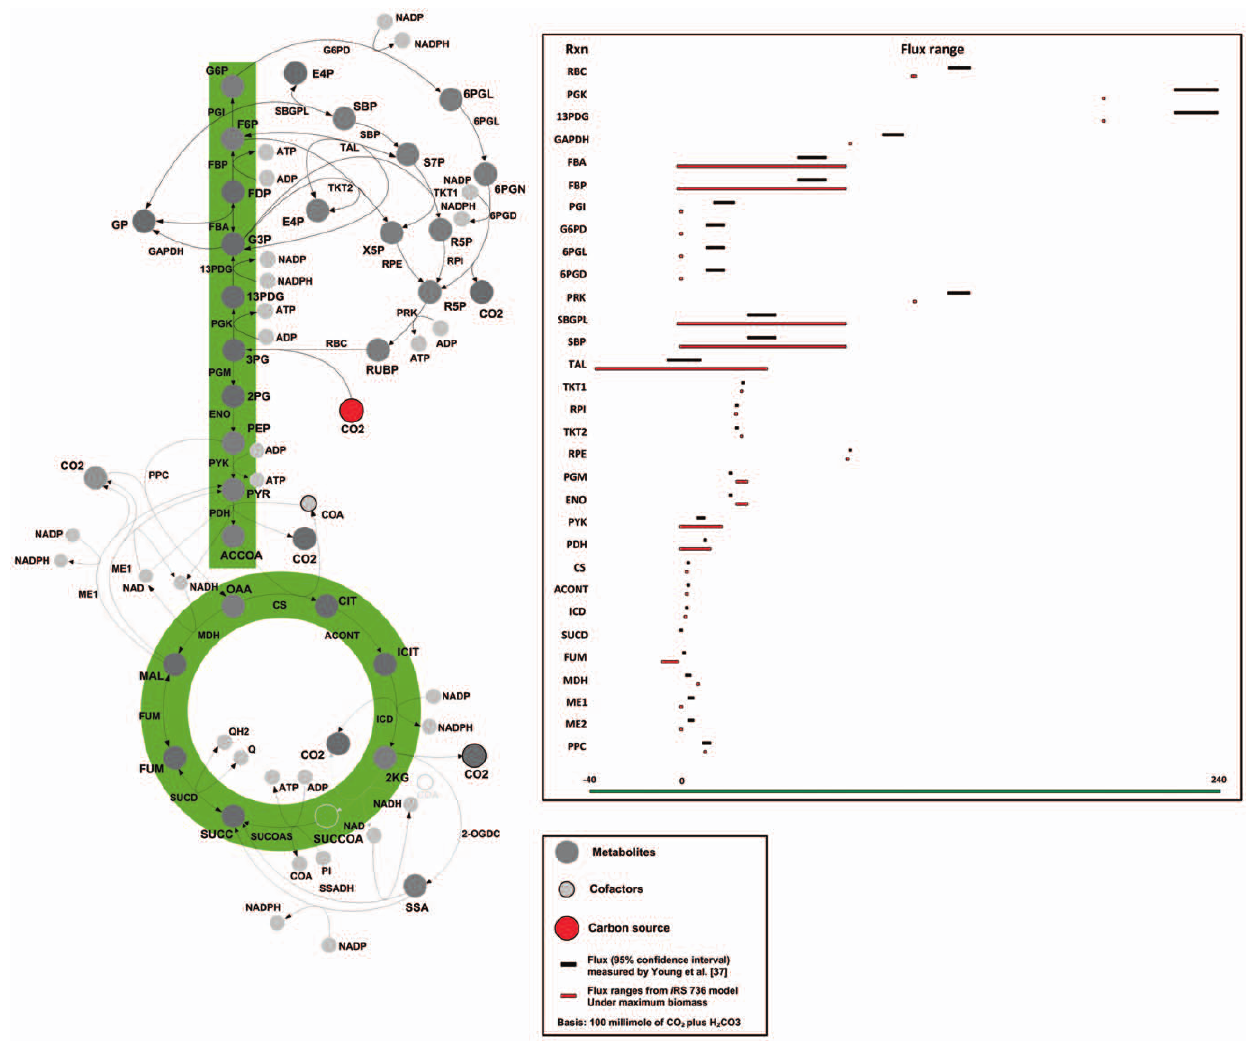
Figure 1. Comparison of model derived and experimentally measured [ 35 ] flux ranges for Synechocystis 6803 under the maximum biomass condition. Basis is 100 millimole of CO 2 plus H 2 CO 3